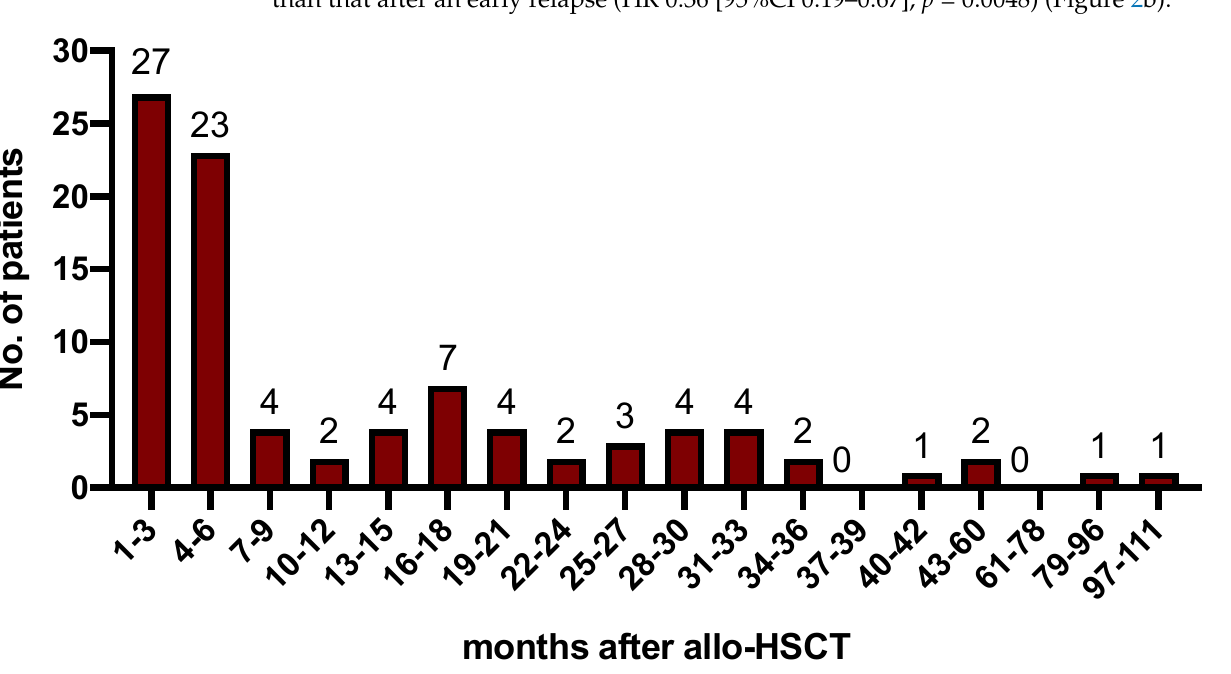
( b ) Figure 2. Outcome after post-transplant relapse. ( a ) Overall survival of the whole cohort ( n = 91), median OS of the whole cohort was 14.1 months (range 0.8–129.3 months) corresponding to a 2-yr OS of 44% [95% CI 32–56%] after relapse. ( b ) Outcome of patients with early and late relapses, patients with late (green line, n = 35) relapse showed a significantly improved outcome compared with patients with early (red line, n = 56) relapse (2-yr OS 66.5% vs. 31.7%, p = 0.0048). Accord- ingly, the hazard to die after a late relapse was significantly lower than that after an early relapse (HR 0.36 [95%CI 0.19–0.67], p = 0.0048). Allo-SCT, allogeneic hematopietic stem-cell transplanta- tion; HR, hazard ratio; CI, cumulative incidence; OS, overall survival; yr, year. 3.3. Comparison of Early and Late Relapses after Allo-SCT For a better understanding of relapse biology, we compared patient-, disease- and transplant-related factors between patients with an early and those with late relapse (Ta- ble 1). The frequencies of molecular and hematologic relapses were evenly distributed within the early and the late relapsed patients ( p = 0.8). Furthermore, the frequencies of AML-MRC and different MDS subtypes at diagnosis did not differ between these groups. Regarding transplant-related factors, no differences in conditioning intensity, donor type or HLA-matching between the groups of patients with early and late relapse were found (Table 1).